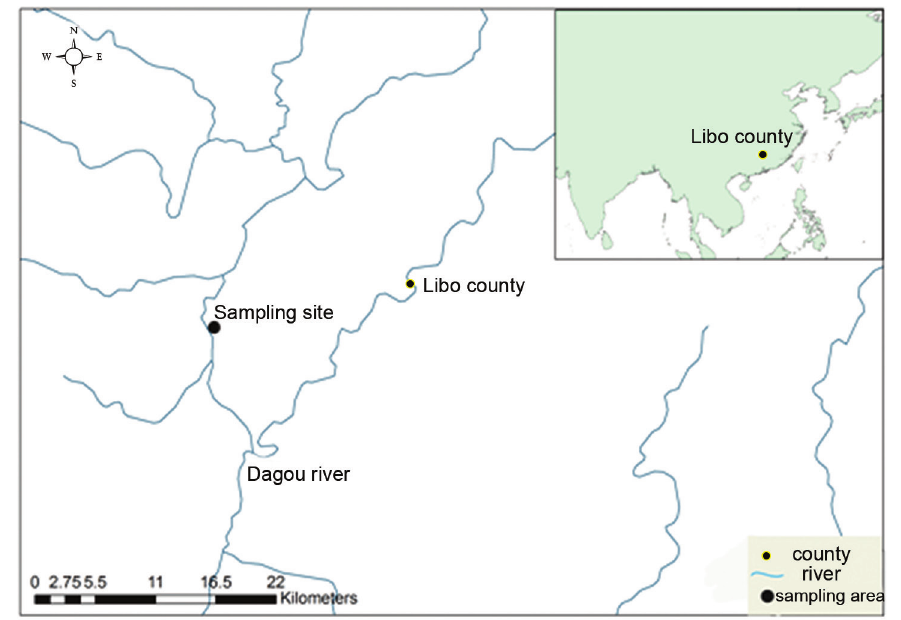
Figure 2. Collection localities of O. daqikongensis sp.